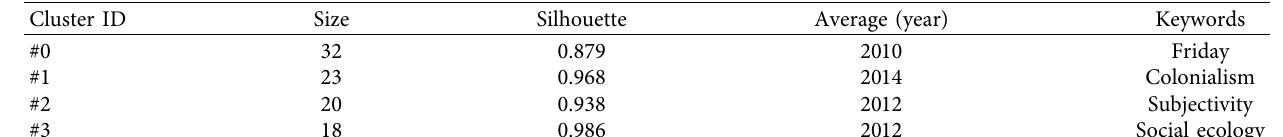
Table 7: Summary of the largest four clusters.